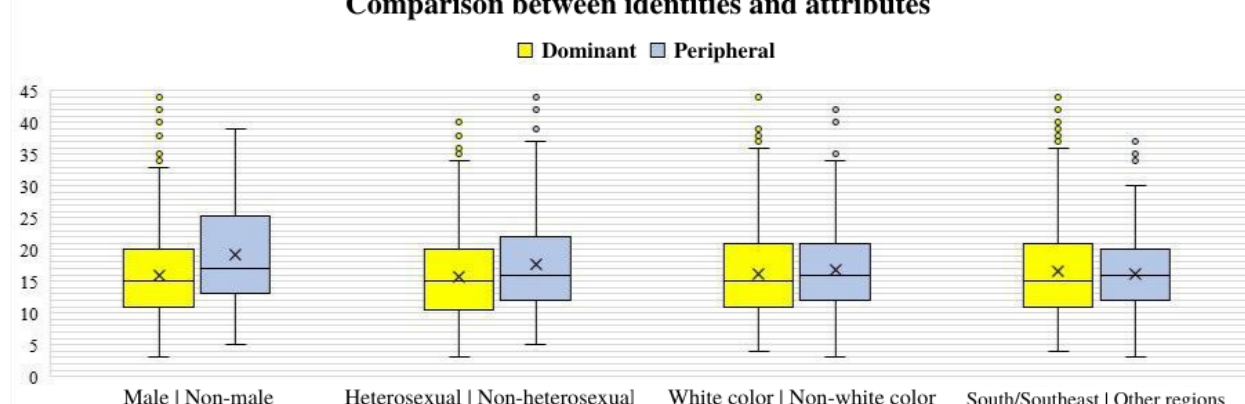
Figure 8 : Boxplot chart of Identity and Attributes by CES-D